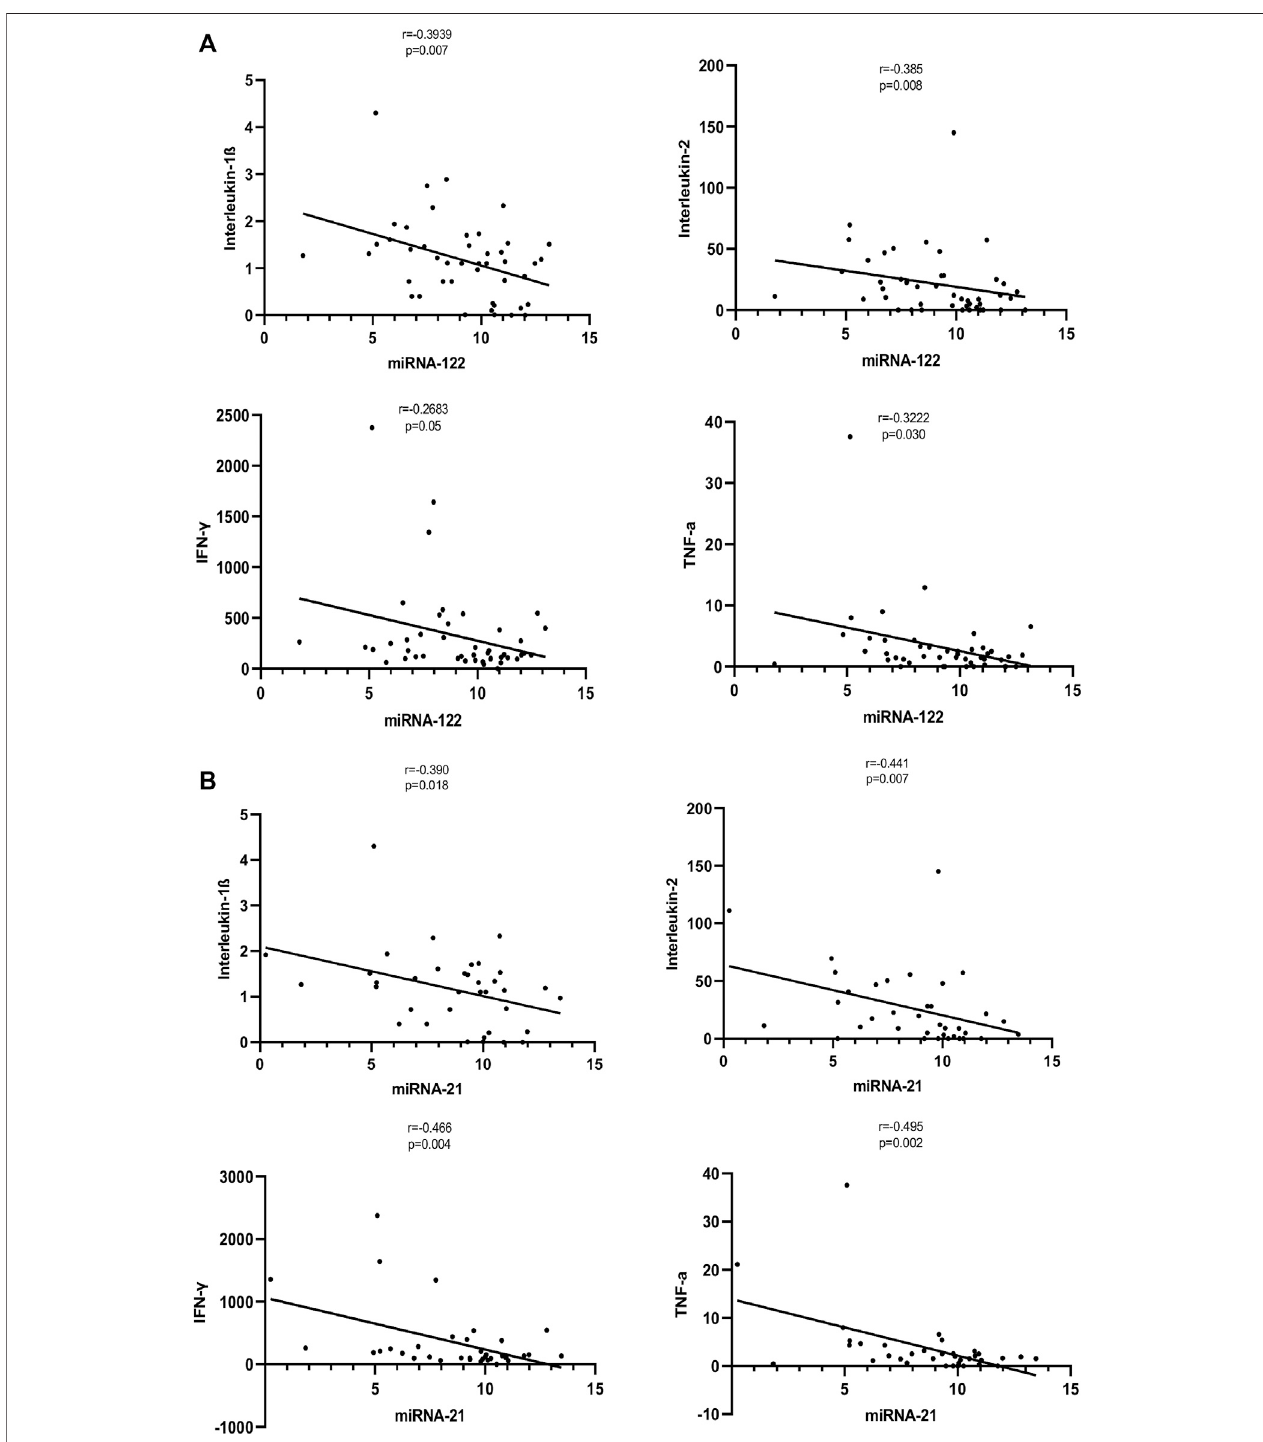
FIGURE 3 | (A) : Correlation of expression levels of miRNA-122 with in fl ammatory cytokines. The X -axis indicates the miR-122 relative expression, while the Y -axis denotes cytokines. We performed the Pearson ’ s correlation test for statistical evaluation. (B) : Correlation ofexpression levels of miRNA-21 with in fl ammatory cytokines. The X -axis indicates the miR-21 relative expression, while the Y -axis denotes cytokines. We performed the Pearson ’ s correlation test for statistical evaluation.